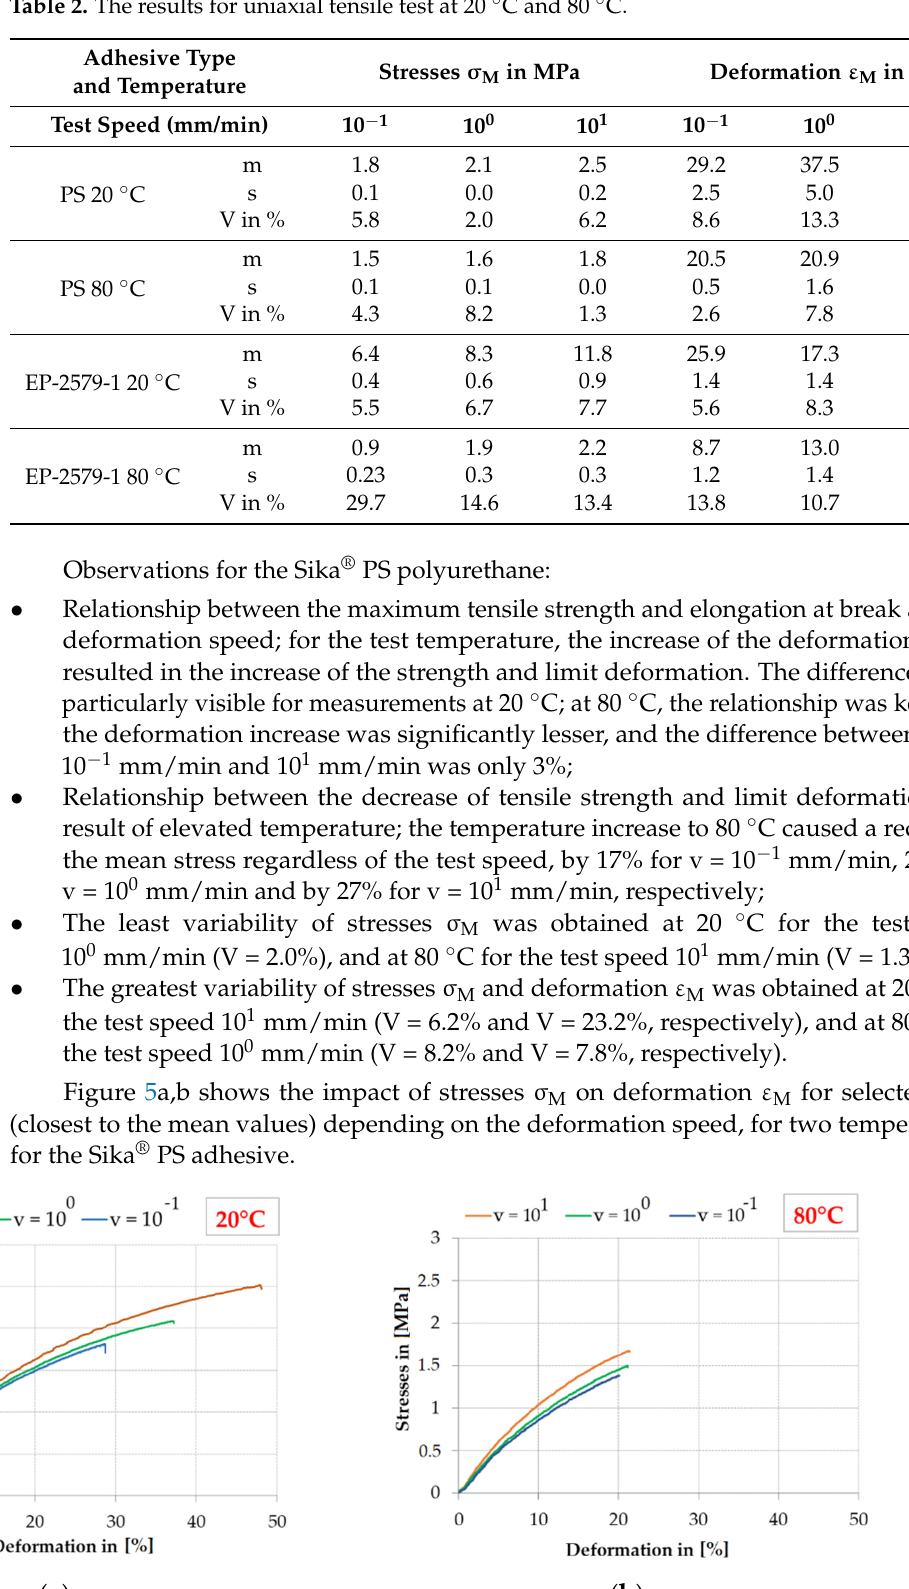
Table 2. The results for uniaxial tensile test at 20 ◦ C and 80 ◦ C.